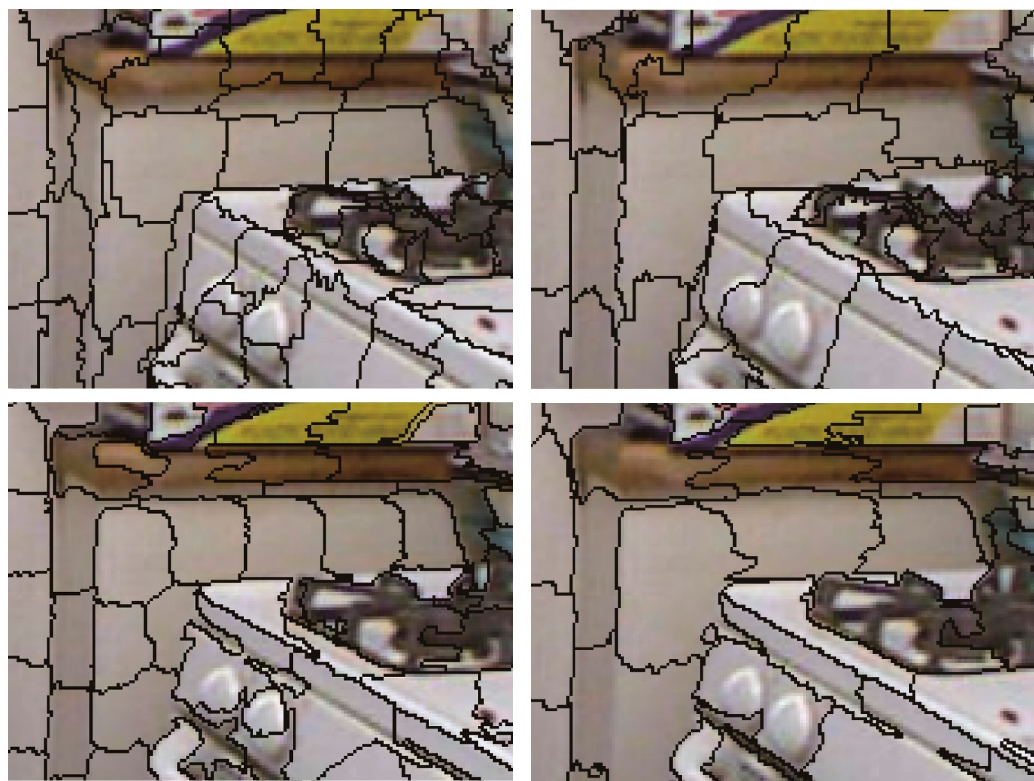
Figure A1. Partially enlarged details of superpixels. From top to bottom are the results from SLIC, DASP, VCCS, and WCFC, respectively. The average superpixel size is approximately 500 pixels in the left column of each image and approximately 300 in the right column.